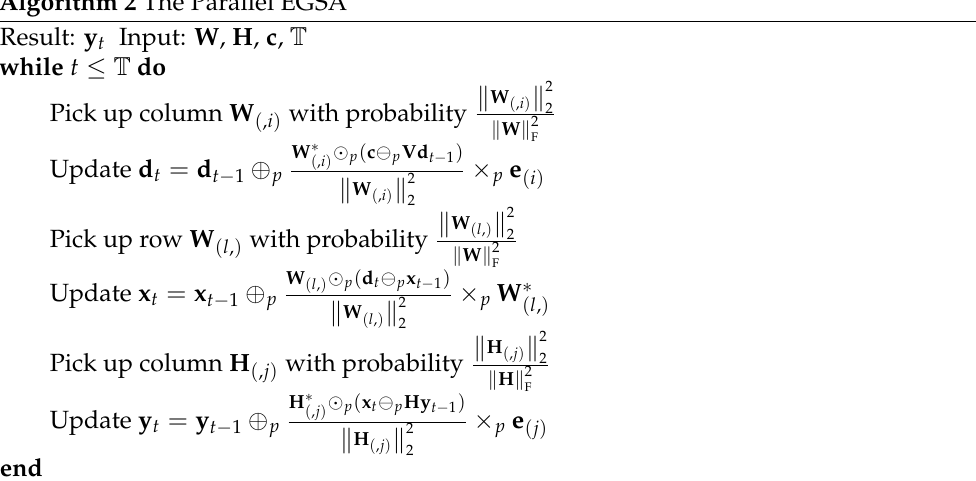
Algorithm 2 The Parallel